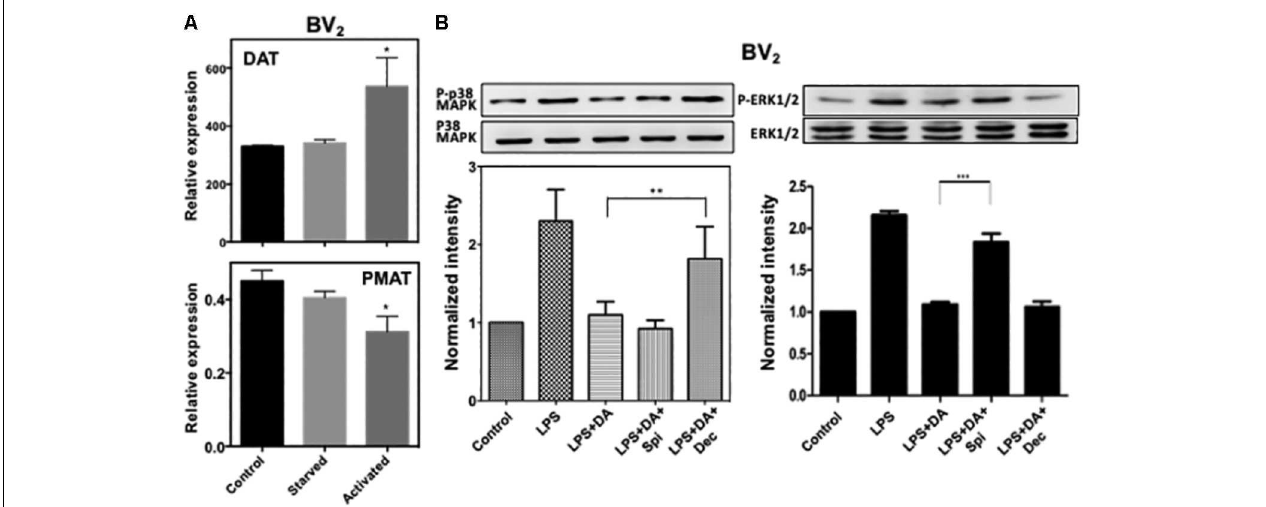
FIGURE 6 | (A) Expression of DAT and PMAT in resting and activated microglia. Quantitative RT-PCR detected mRNA for DAT and PMAT in resting and activated BV 2 microglia. The expression level of DAT increased significantly in activated microglia while PMAT expression decreased. (ANOVA: ∗ P < 0.05 compared to control). (B) Activation of p38MAPK resulted from the activation of microglia by LPS can be blocked by decynium while activation of ERK1/2 can be blocked by spiperone (ANOVA: ∗∗ P < 0.01, ∗∗∗ P < 0.005).